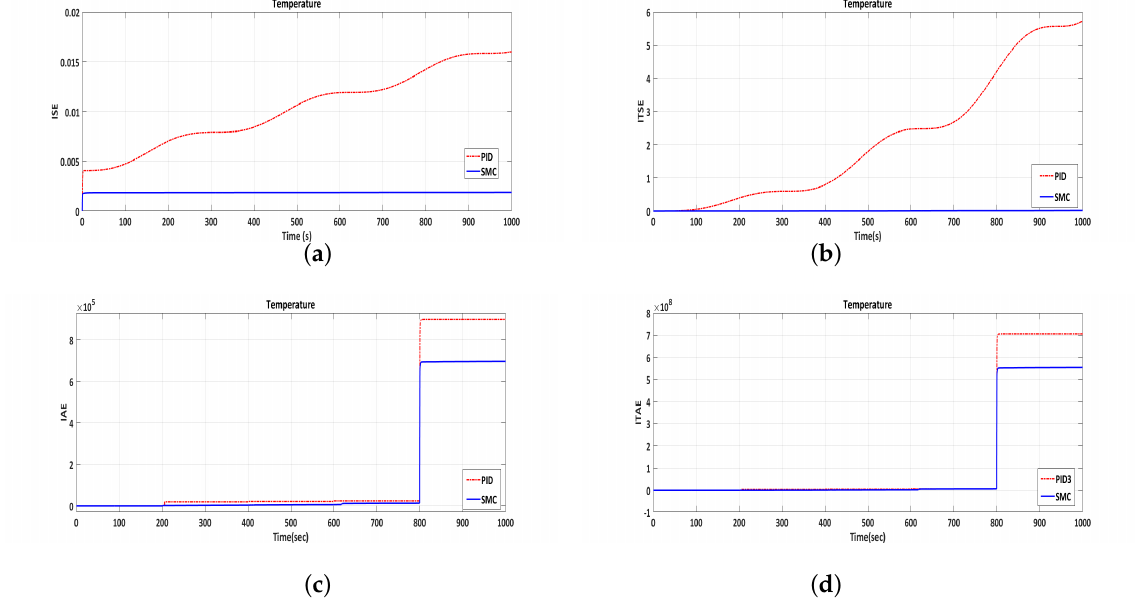
Figure A5. Performance indices ( a ) ISE, ( b ) ITSE, ( c ) IAE, ( d ) ITAE graph of controllers for temperature output of the third reference signal, combination of ramp with steps and multilevel